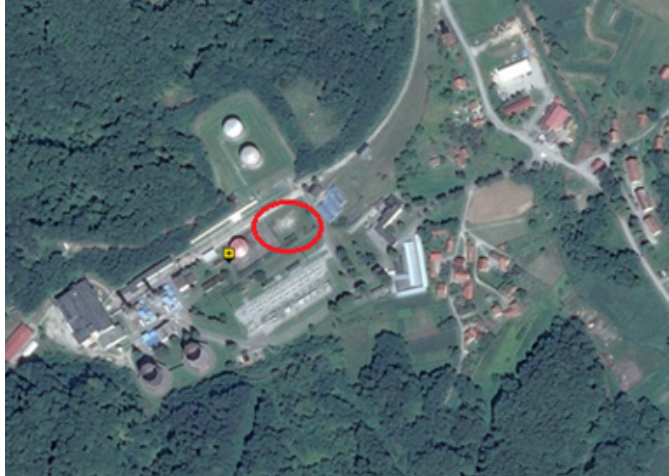
Figure 1. Geographical area of power plant Jertovec with red circle indicating the location of the potential